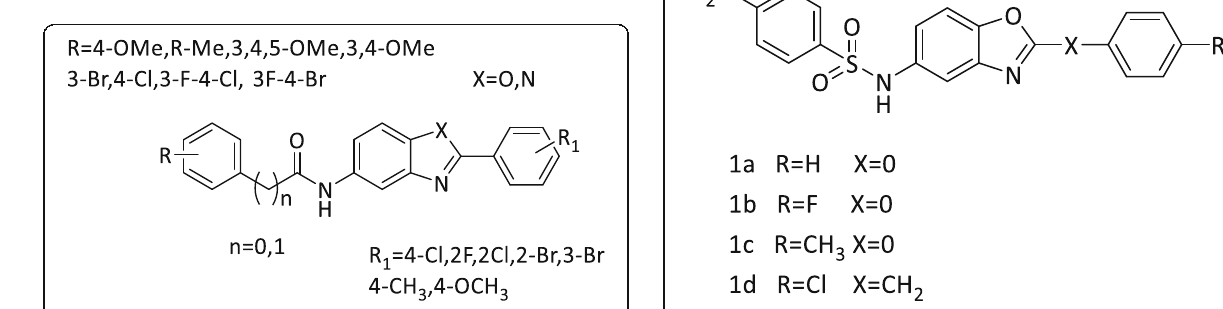
Fig. 30 Benzoxazole-sulphamide antitumor